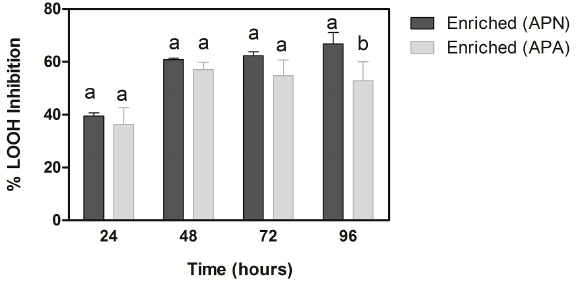
Figure 3. Inhibition of lipid peroxidation over time in a model emulsified lipid with enriched tomato juice added with phenolic extracts. APN, neutral phenolic extract; APA, acidic phenolic extract. Different letters in the same time slot indicate significant differences between extracts.